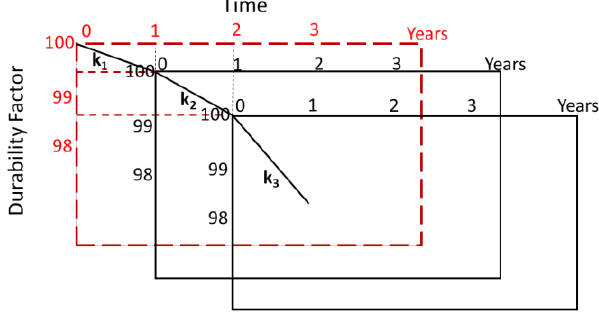
Figure 4. Conceptual diagram of the relationship between durability factor and elapsed years.